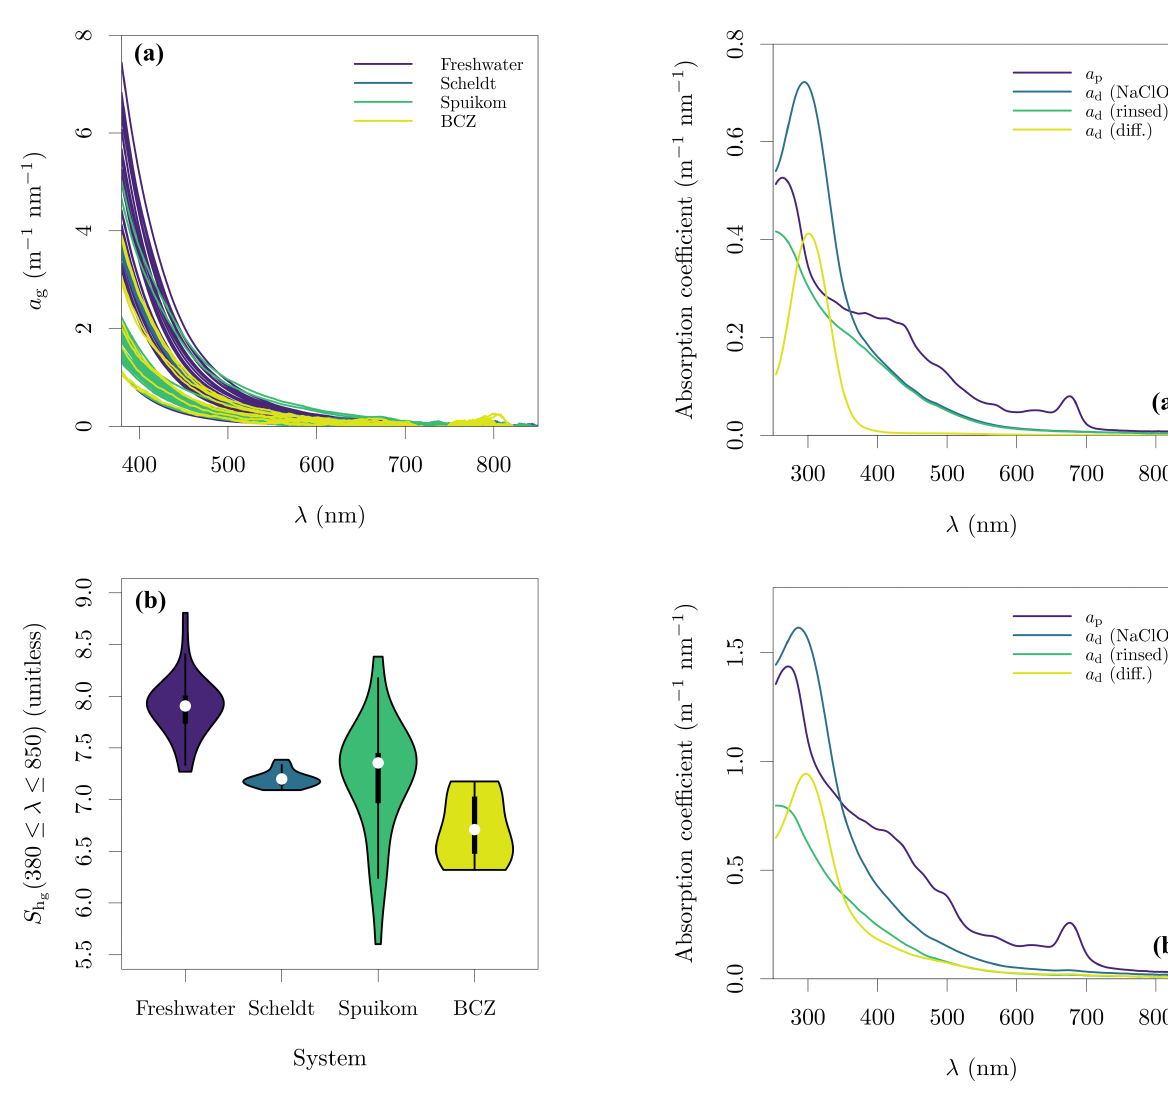
Figure 2. Evaluation of the treatment of filters with sodium hypochlorite (NaClO) and subsequent rinse on the determination , fitted in the of a d . (a) A sample from the Bocht (BL_08) and (b) a sample from g the Dikkebus (DK_01). The sample in panel (b) shows loss of ab- sorbing material after